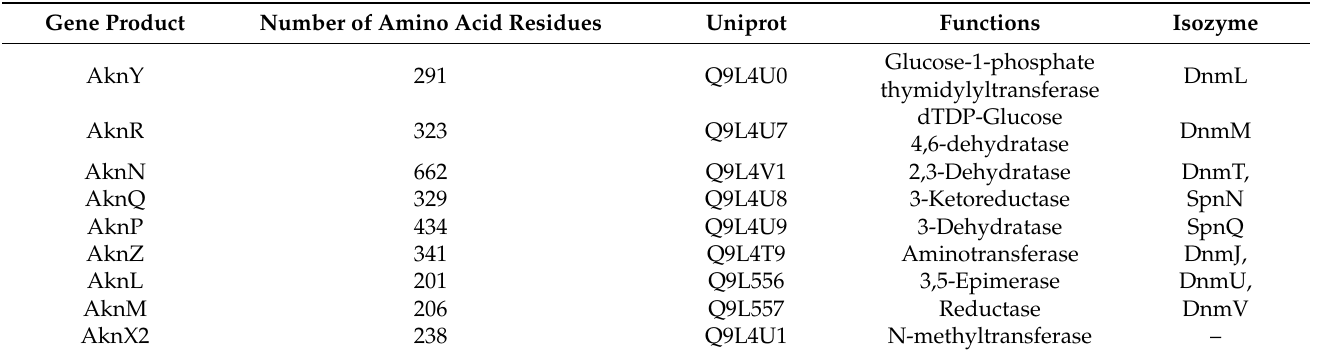
Table 2. The identified and putative functions of akn enzymes and isozymes. Gene Product Uniprot